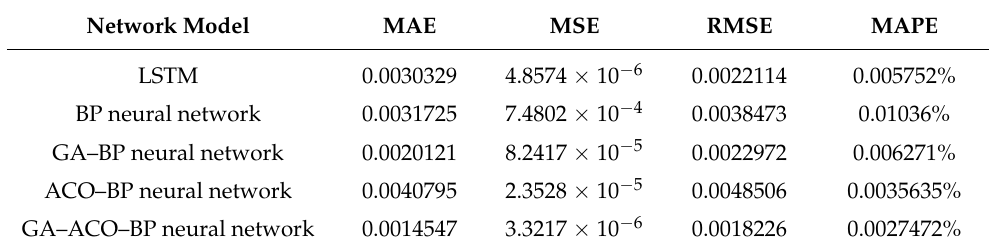
Table 4. Error comparison table of each model.